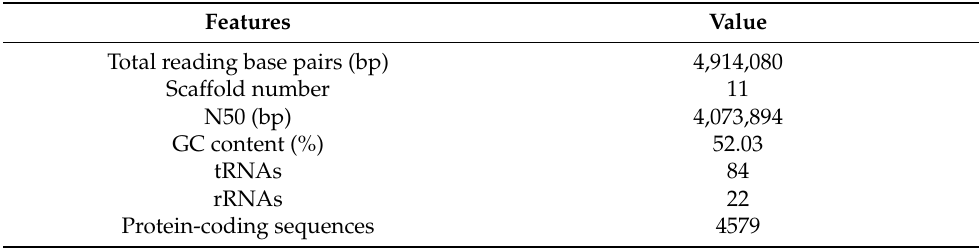
Table 3. Features of the S . Derby 14T